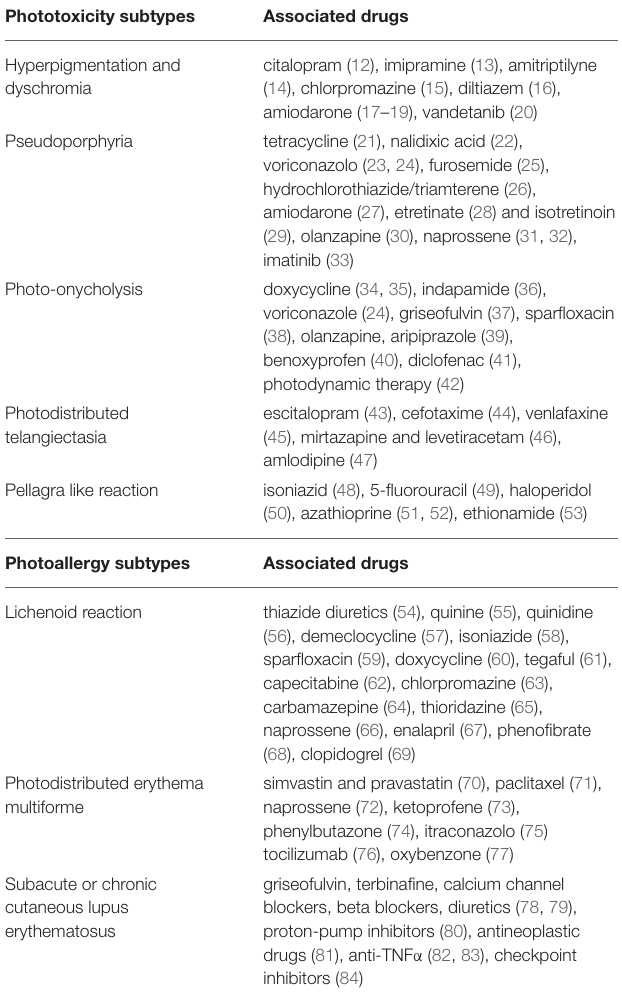
TABLE 1 | Drugs associated with phototoxicity and photoallergy